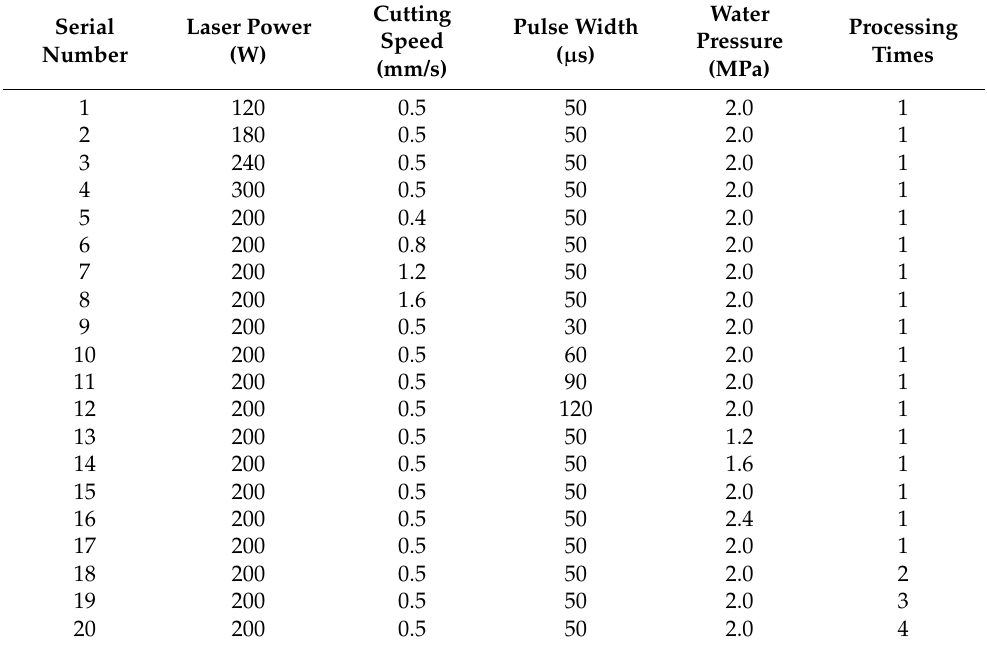
Table 4. Single-factor experiment